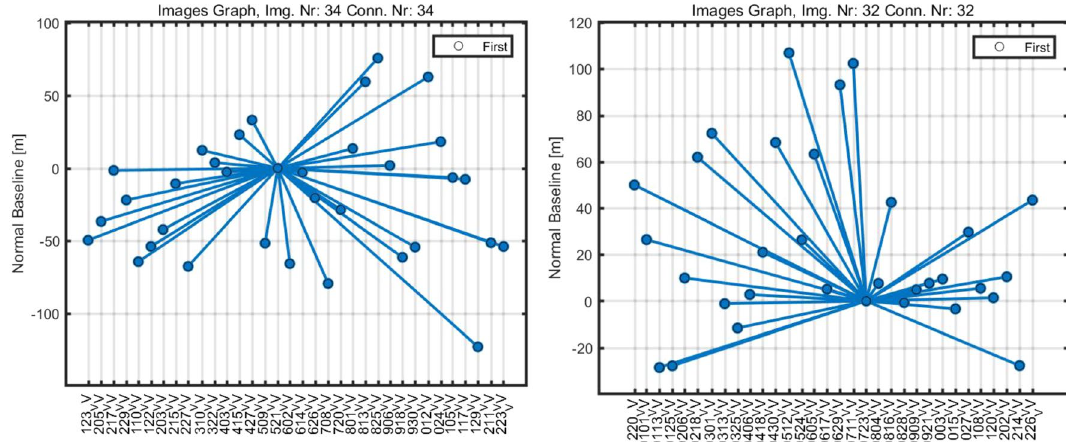
Figure 5. Star graphs depict the perpendicular/temporal baseline distribution of data pairs.